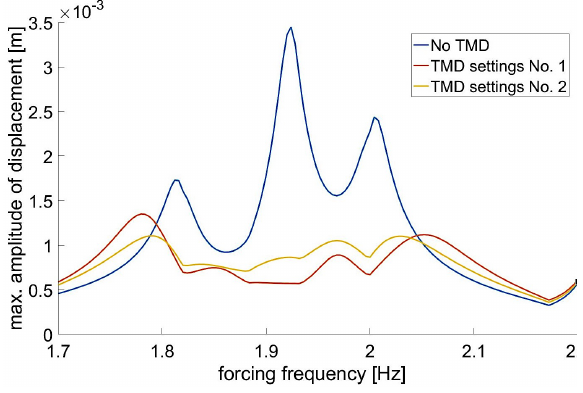
Figure 6. FRF - settings No. 1-2.